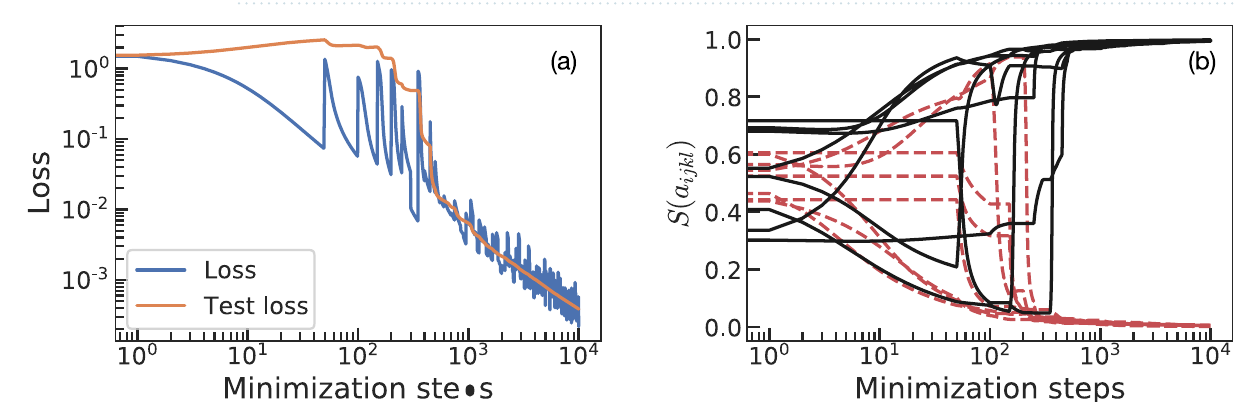
Figure 2. Training on the ones and twos addition facts. Learning on each task lasts for 2000 minimization steps (marked by the vertical black dashed lines). Panel ( a ) depicts the value of the loss function for each task during training. Panel ( b ) shows S ( a ijkl ) for the 16 parameters of the model ( a ijkl ): if learning succeeds black solid lines should tend to 1 whereas red dashed lines should go to 0. Two black lines stay approximately constant due to the lack of the necessary information in the dataset (see main text). Learning shows two distinct regimes with different power law behavior. The two non-vertical black dashed lines in panel ( a ) correspond to exponents ∼ − 0.2 and ∼ − 1 .